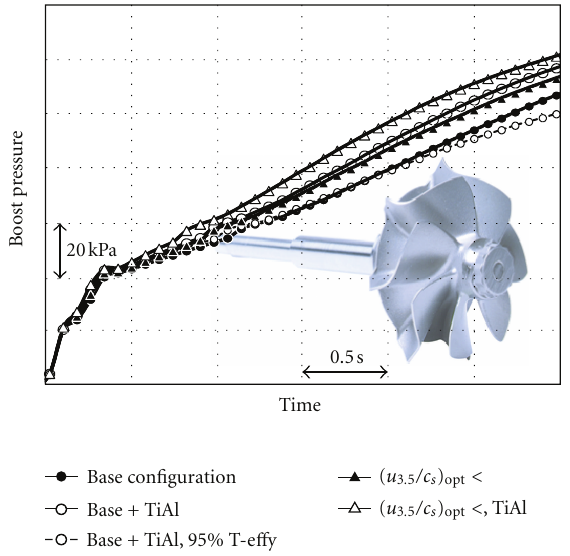
Figure 19: Increase of boost pressure versus time depending on di ff erent turbine configurations.